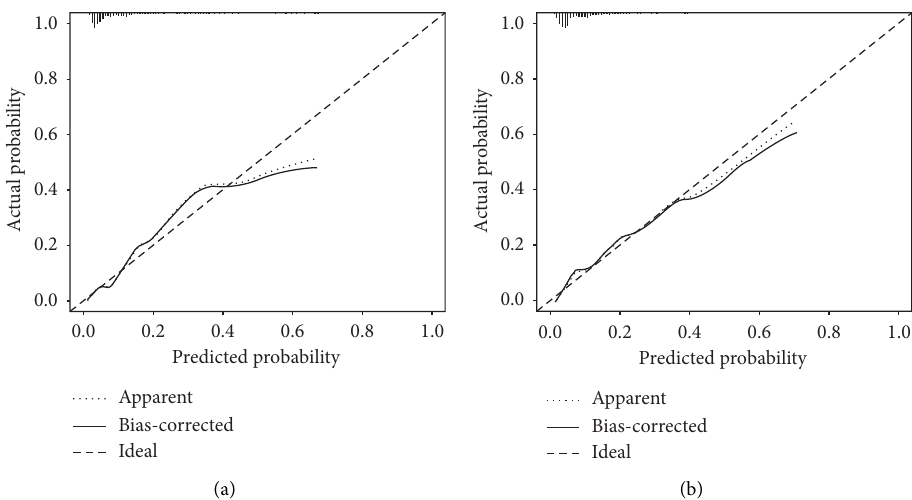
Figure 2: (a) Validity of the predictive value of the nomogram for the estimation of the risk of CI-AKI in the development cohort. (b) Validity of the predictive value of the nomogram for the estimation of the risk of CI-AKI in the validation